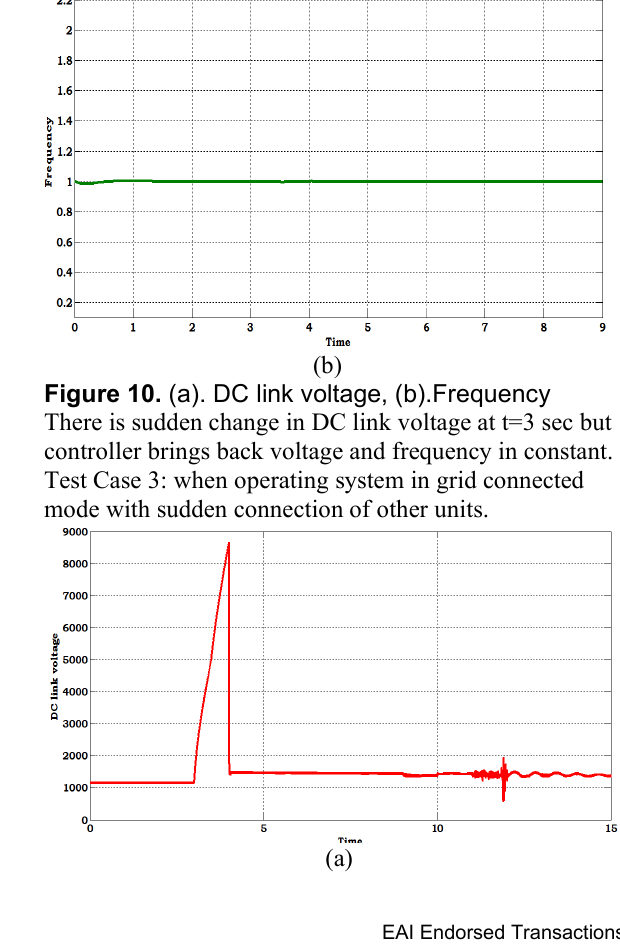
From t=0 sec to t=3sec, the DC link voltage is maintained